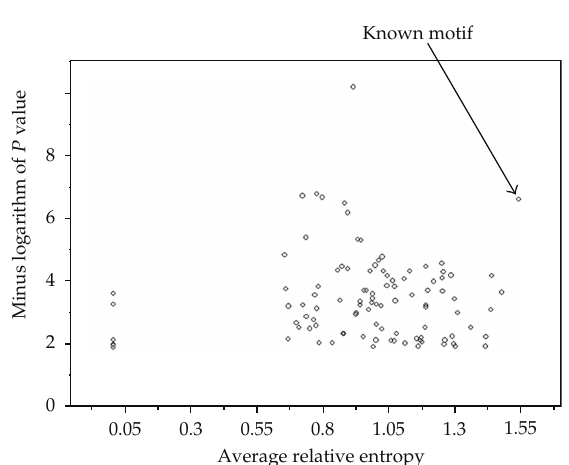
Figure 2: Average relative entropy of the motifs. We choose the 100 sequences found in the upstream of Ace2-regulated S. cerevisiae genes with the smallest overrepresentation P -values and compute their average relative entropies in the multiple alignments of orthologous upstream sequences of the four related species. The results were displayed with a scatter plot of P -value versus average relative entropy. The arrow points to the known binding motif GCTGGT of Ace2 in S. cerevisiae . The average relative entropy of the known binding motif is greater than that of most other